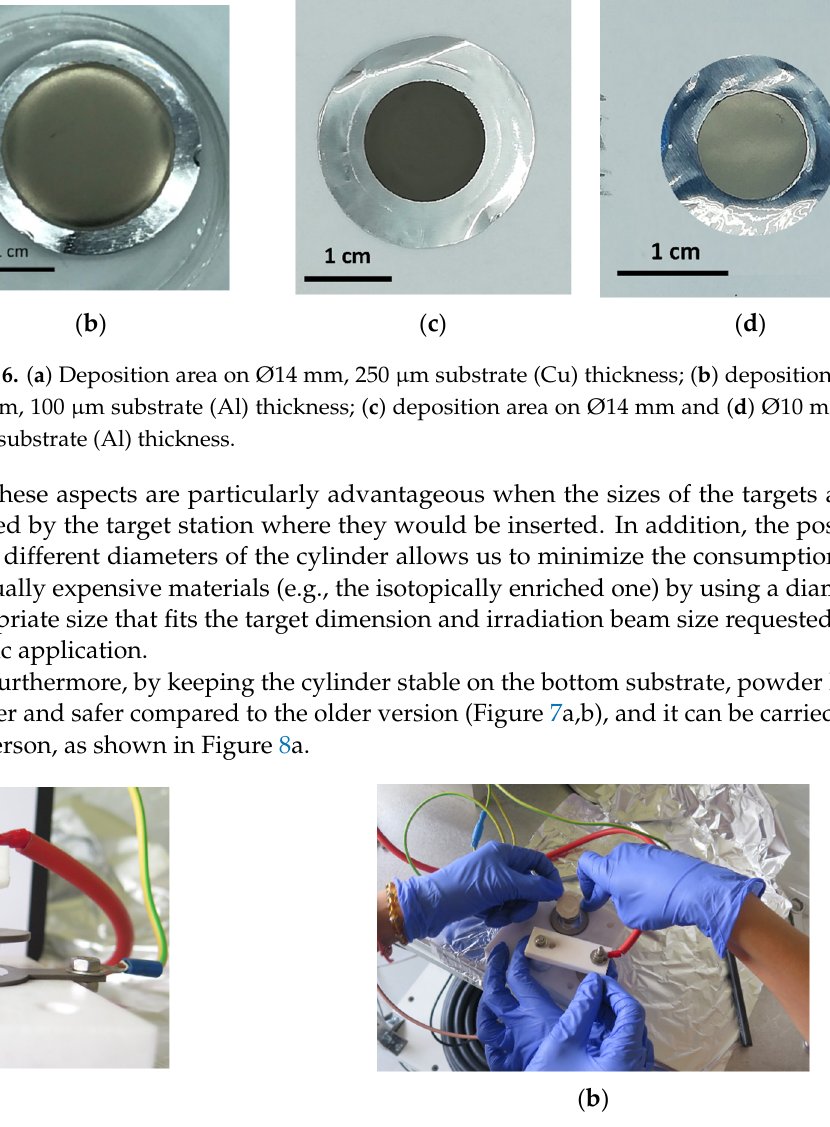
Figure 7. First version of the sample holder according to the design by I. Sugai [2]: ( a ) picture of assembled sample-holder; ( b ) assembly step by two people.